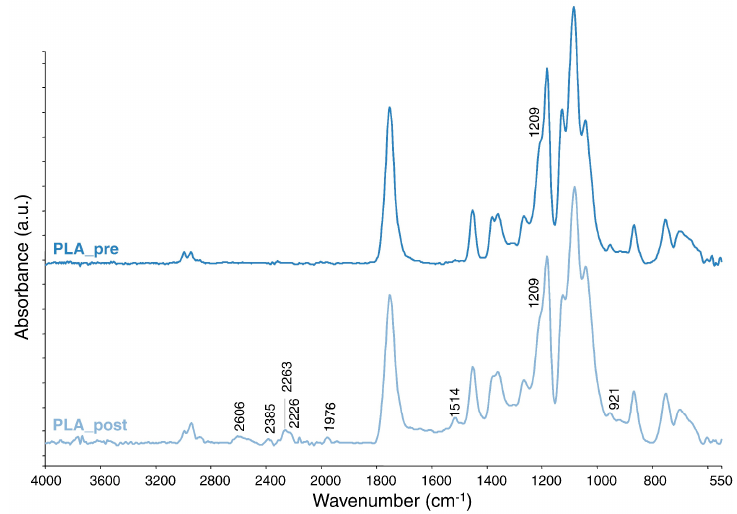
Figure 4. FTIR spectra of tested and untested PLA filters.